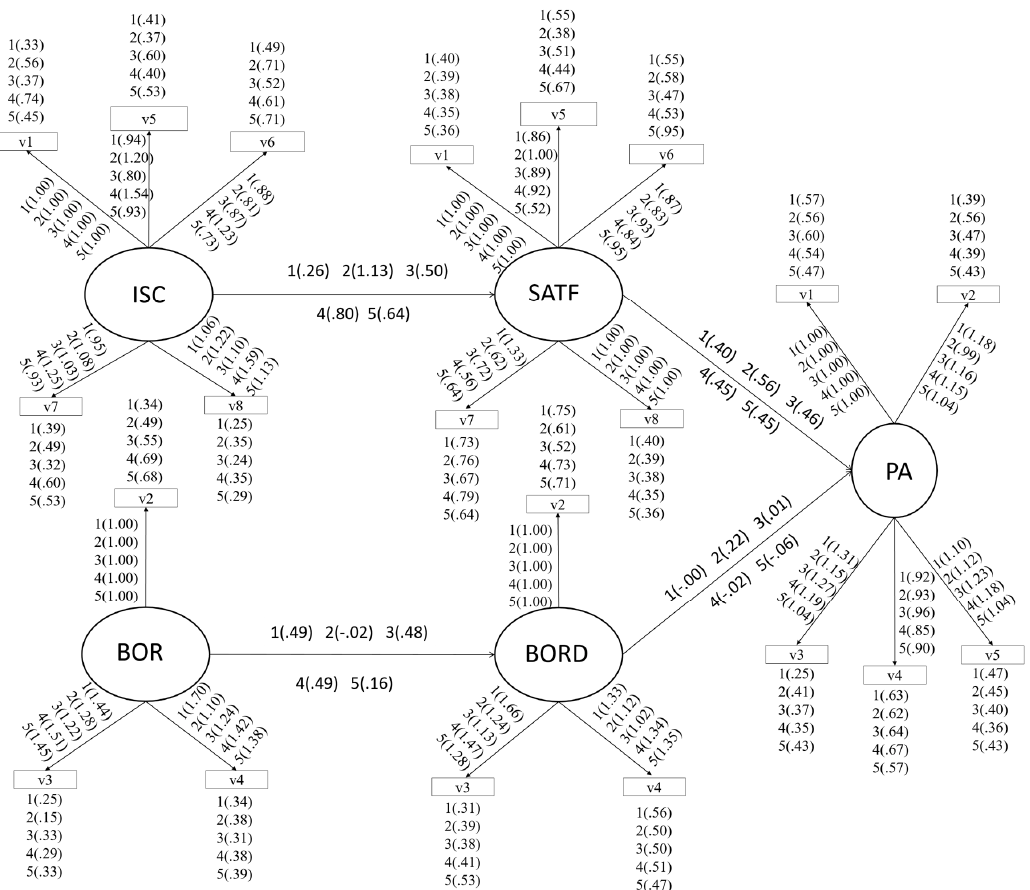
Figure 1. Path diagram for all subjects. Note: Physical education (PE) (1), geography and / or history (GH) (2), English (ENG) (3), Spanish (SP) (4), and mathematics (MAT) (5); ISC: Intrinsic satisfaction classroom with subjects; PE: Boredom with subjects; SATF: Satisfaction with school; BORD: Boredom with school; PA: Performance, academic.